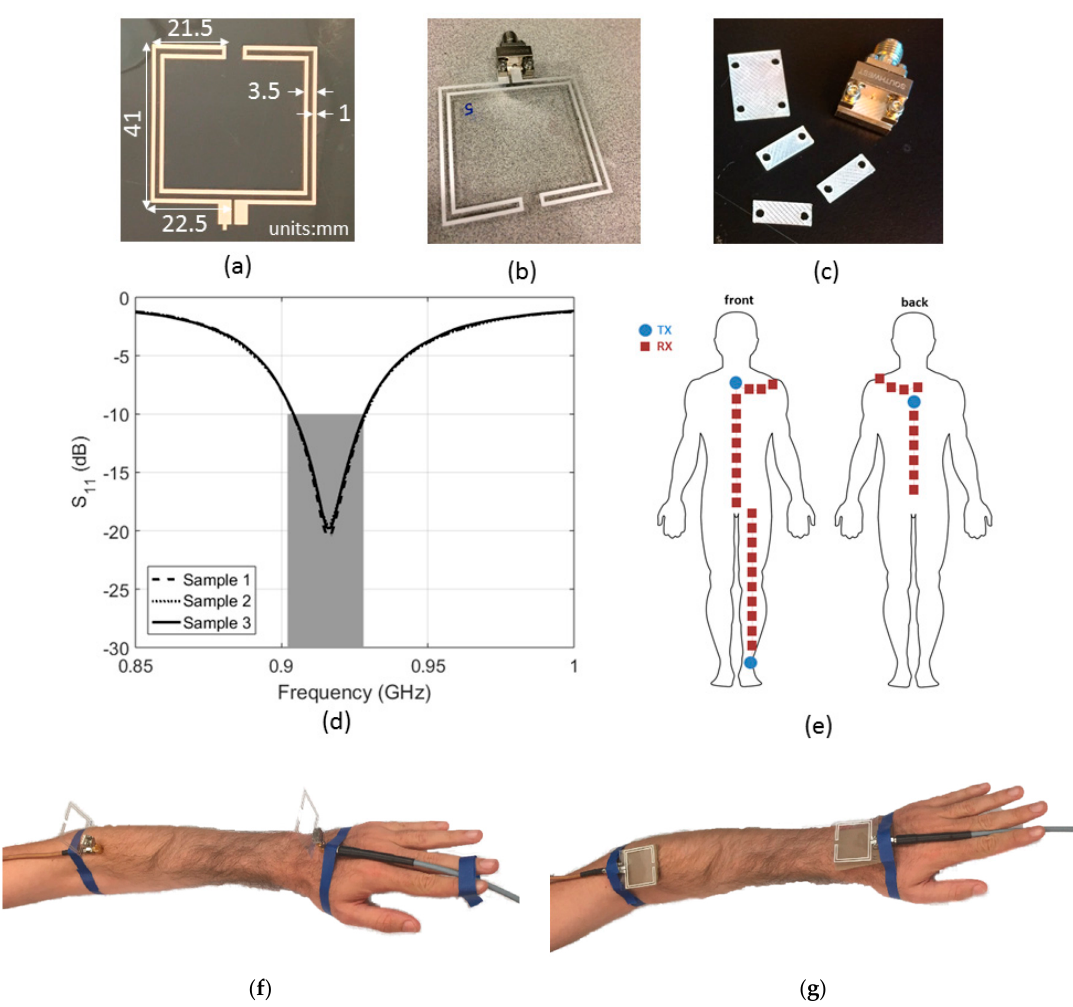
Figure 2. ( a ) Screen-printed folded dipole on PEN with antenna dimensions (mm). ( b ) Screen-printed folded dipole with the used mechanical SMA connector ( c ) The used mechanical SMA connector with the printed plastic spacer. ( d ) Measured S 11 of three printed antennas (black) and the UHF RFID frequency band (grey). ( e ) Additional on-body path-loss configurations used for measurements using this antenna. ( f ) On-body setup in the reference scenario with antennas orthogonal to the skin surface and ( g ) On-body setup in the reference scenario with antennas parallel to the skin surface.